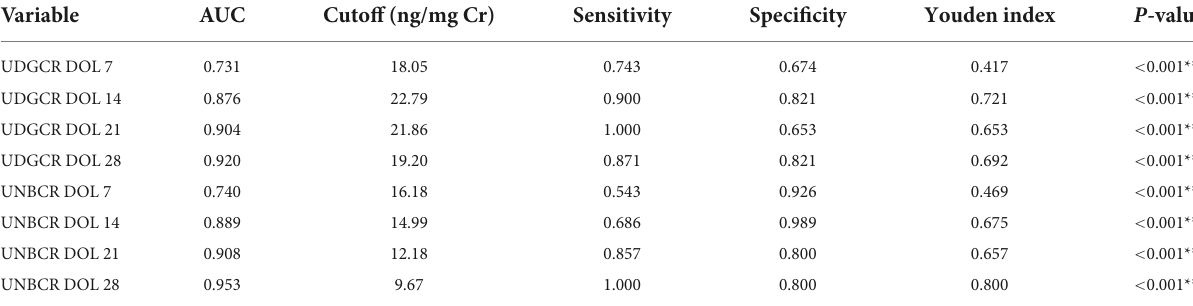
TABLE 2 UDGCR and UNBCR cutoff values for predicting BPD.